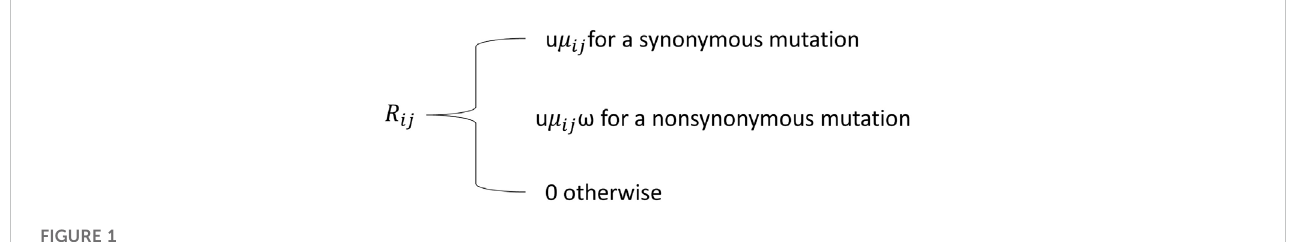
FIGURE 1 Simple model for substitution rates, where Rij is a nonsynonymous rate, u is a proportionality constant and μ ij is the rate at which i mutates to